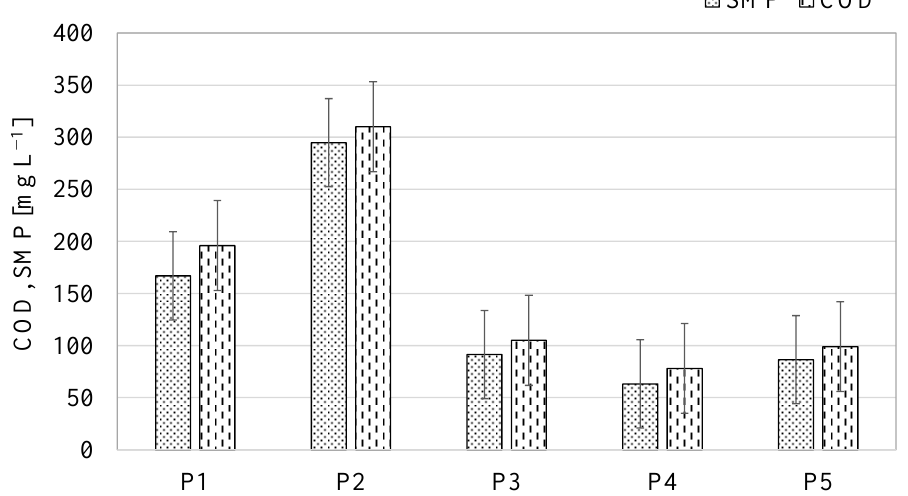
Figure 6. Concentrations of COD and SMP in the supernatant of the ASSR during the